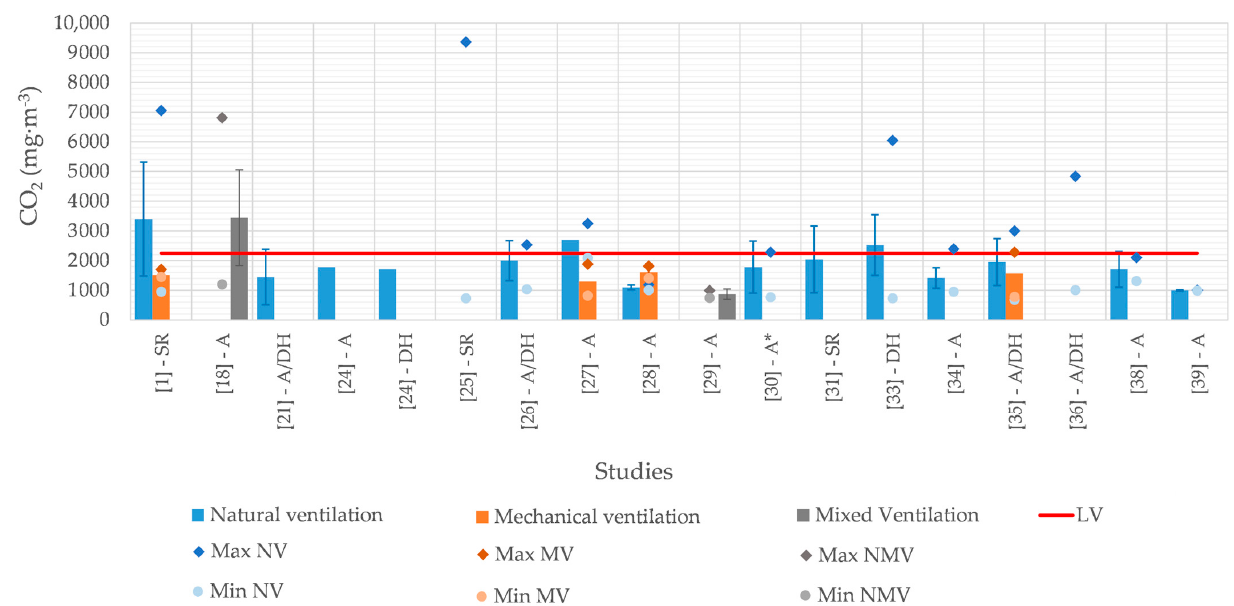
Figure 4. Carbon dioxide levels monitored in bedrooms, with natural (NV), mechanical (MV) and mixed (NMV) ventilation settings. Studies index is regarding type of building: A—apartment; A/DH—mixed (apartment and detached house); DH—detached house; SR—scholar residence. Bars provide mean values (along with standard deviation when available). Max and min stand for maximum and minimum values, respectively. *—This study does not specify the type of bedroom ventilation. LV stands for the limit value established by the Portuguese Ordinance no. 353-A/2013 [44].